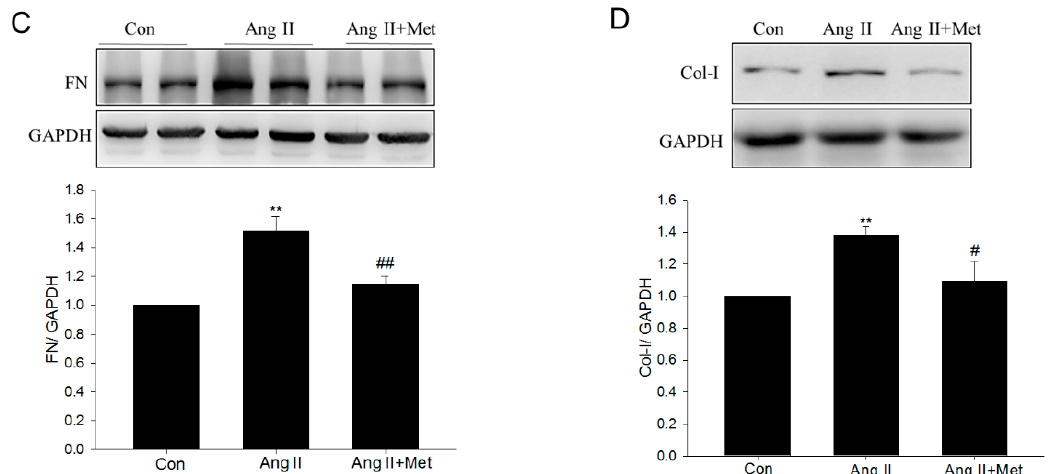
Figure 7. Effect of metformin on angiotensin II–induced ECM production in renal fibroblast NRK-49F cells. ( A , B ) The cells were stimulated with 1 μ M angiotensin II (Ang II) for 24 or 48 h. Fibronectin (FN) and collagen I (Col-I) were assayed by Western blot analysis; ( C , D ) After 48 h of Ang II treatment, with or without 1 h metformin pretreatment. Fibronectin and collagen I were assayed by Western blot analysis. Data are the mean ± SEM of three experiments. ** p < 0.01 compared with control (Con); # p < 0.05, ## p < 0.01 compared with Ang II only.